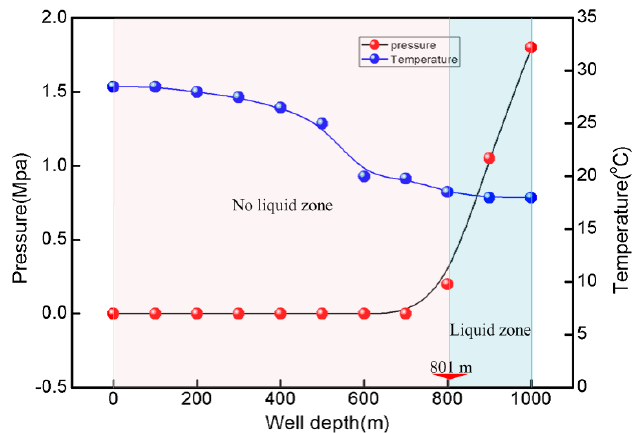
Figure 25. Downwell temperature, pressure and liquid level distribution.